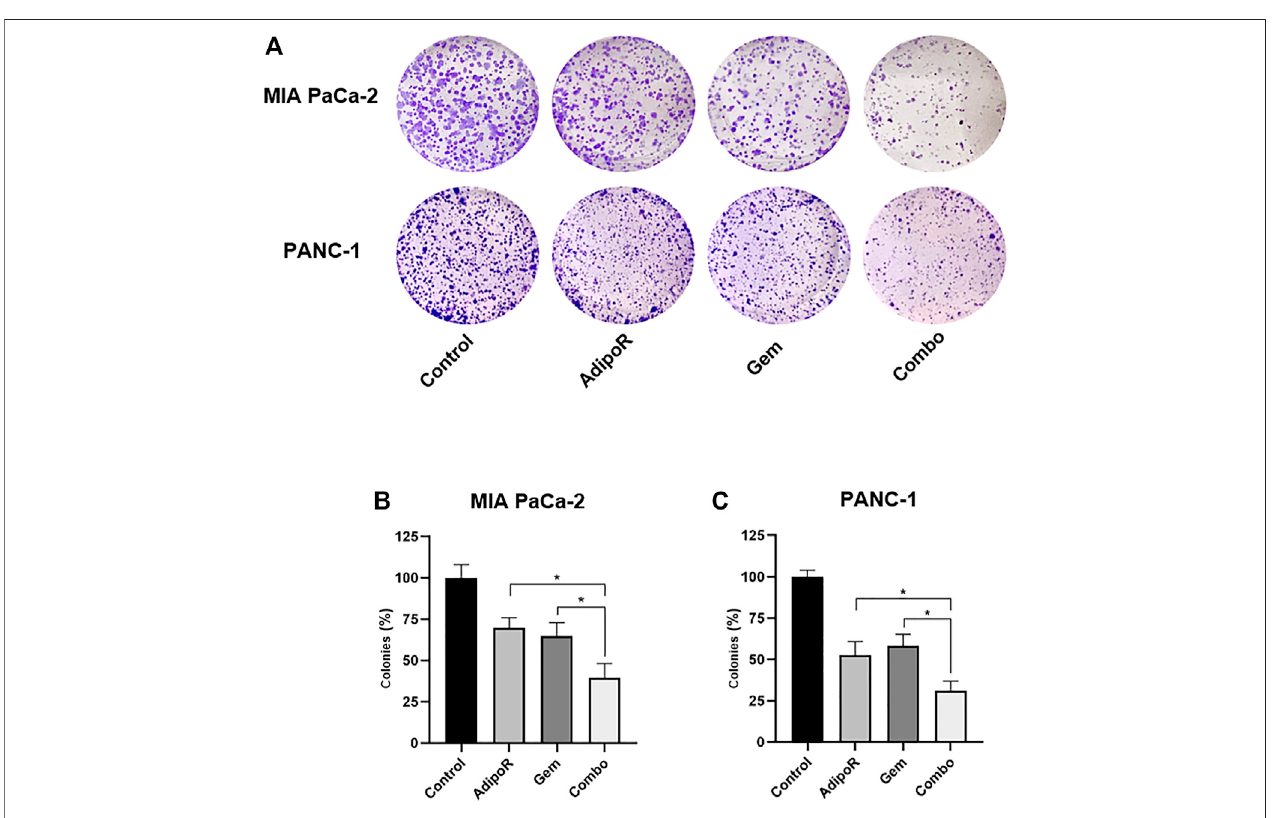
FIGURE 3 | Estimation of single and combinatory impacts on clonogenic potential in PDAC cells. MIA PaCa-2 and PANC-1 were treated and not (control) with the same AdipoR concentration (2 µg/ml) but different Gem amounts (4 vs 6 nM), both individually and in combination, for 8 and 10 days, respectively. Representative stainedwellsaredisplayed in (A) ,while therelativequanti fi cation analysishasbeenreportedin (B) (MIA PaCa-2)and (C) (PANC-1).Experimentswerereproducedthrice and plotted on a graph as mean value ± SD in % of control. * p < 0.05 by Tukey ’ s multiple comparisons test.